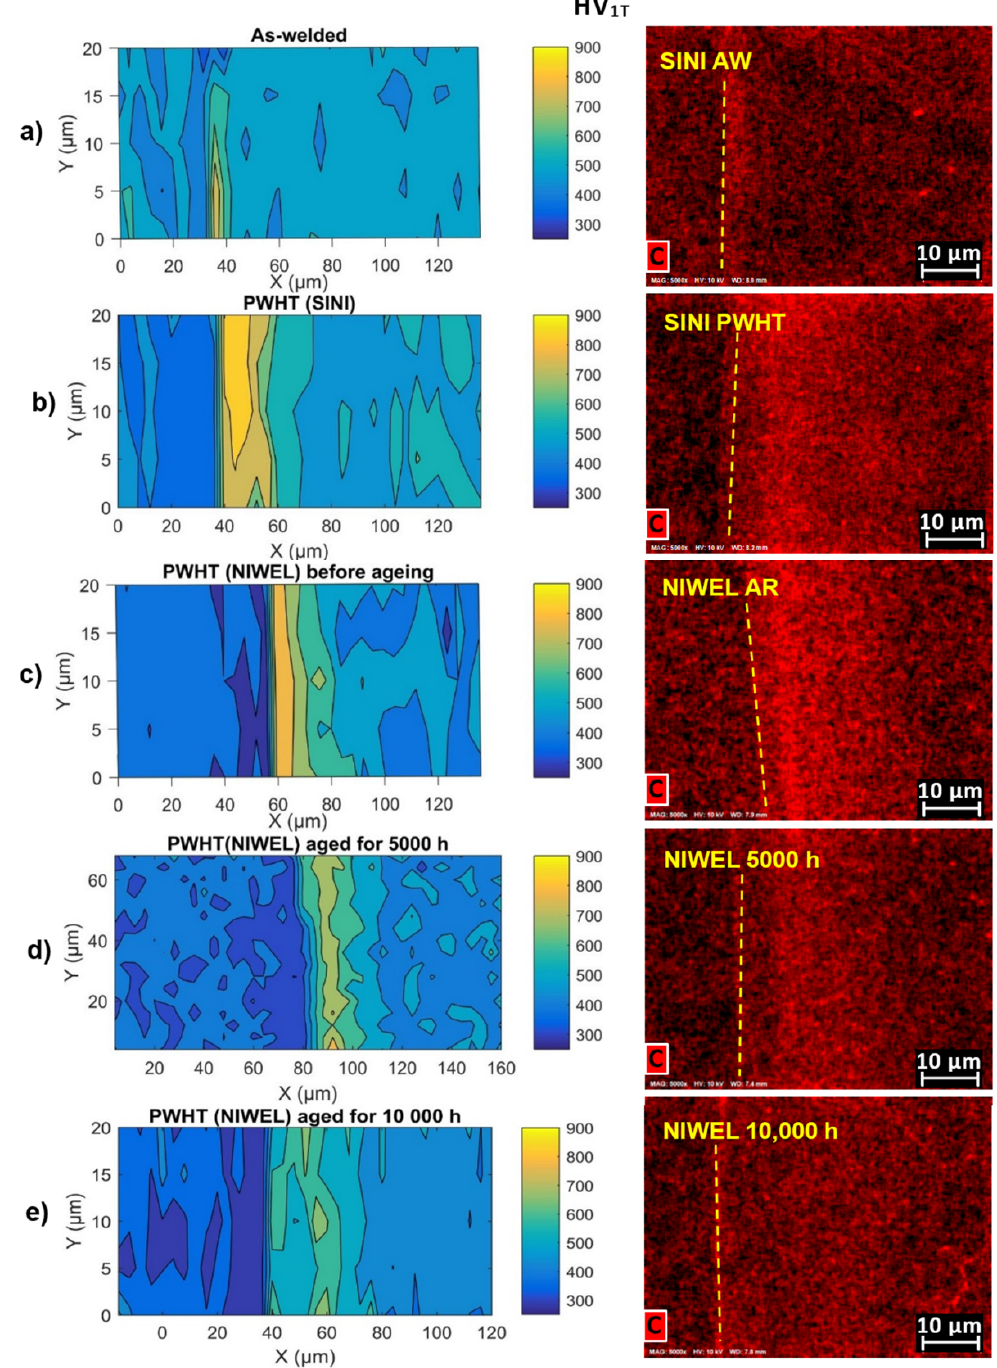
Figure 15. Nanoindentation hardness profiles (1.5 mN) across the LAS / Alloy 52 weld metal interface in all conditions, with the corresponding EDS maps showing the carbon concentration in ( a ) SINI AW, ( b ) SINI PWHT, ( c ) NIWEL AR, ( d ) NIWEL 5000 h and ( e ) NIWEL 10,000 h conditions. A clear correlation is seen between the hard layer in Alloy 52 weld metal near the FB and the carbon-rich layer in the EDS maps.